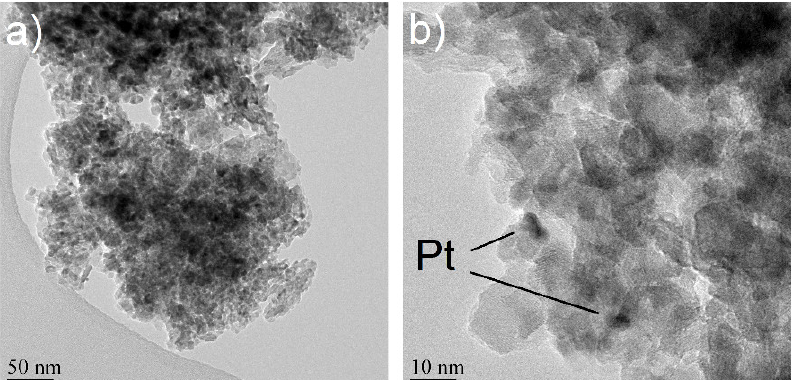
Figure 3. TEM images from the fresh diesel oxidation catalyst with ( a ) lower and ( b ) higher magnification.